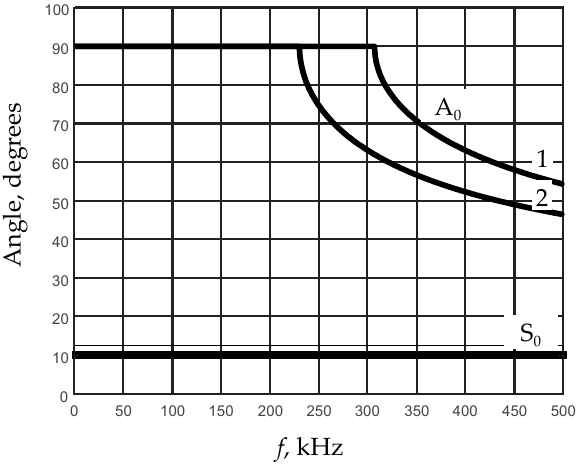
Figure 4. Dependences of the deflection angles of air-coupled ultrasonic transducers for PVC films of different thickness: 1— d = 150 µm, 2— d = 200 µm.